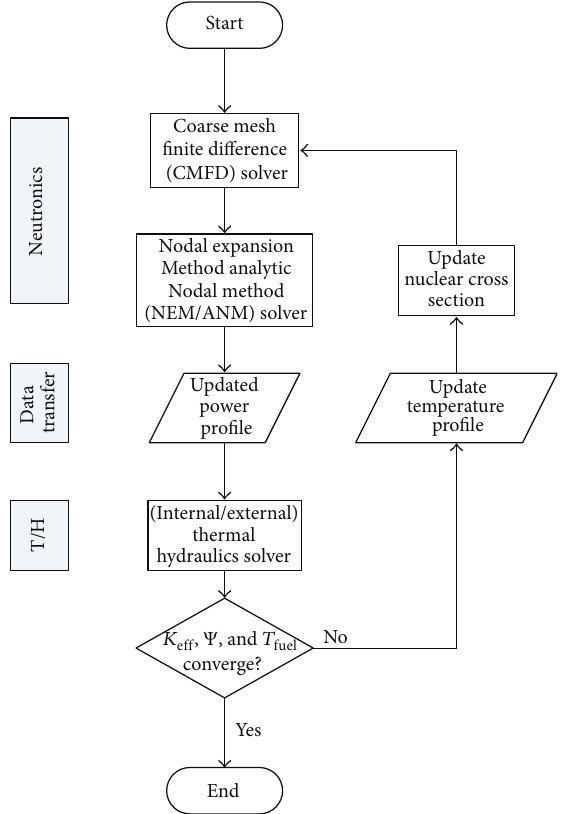
Figure 2: Solving scheme for steady state eigenvalue problem in